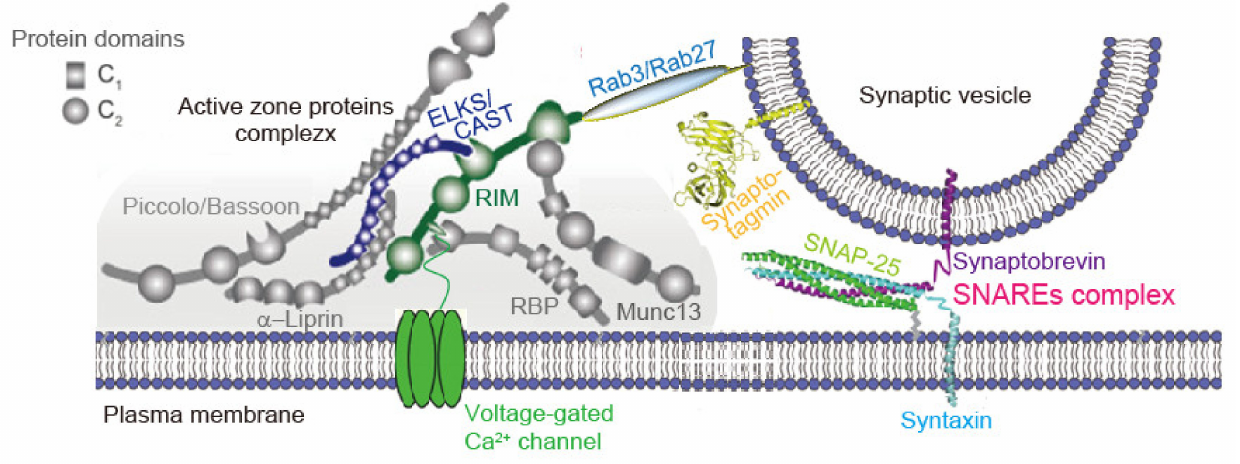
Figure 1. Presynaptic active zone assembly model and synaptic vesicle fusion machinery proteins. Diagram represents active zone (AZ) proteins’ complex in a liquid droplet (gray) and a docked synaptic vesicle (SV). A recent in vitro study indicates that SVs coat the surface of condensed liquid droplets [37]. In the droplet, the AZ is a highly organized structure that recruits voltage-gated Ca 2+ channel and docks SV. Reproduced with permission from ref. [3]. Copyright 2016, Wang et al. Priming factors promote proper assembly consisting of the pre-fusion state of the fusion machinery protein complex and SNAREs/synaptotagmin/complexin (not shown) [38]. The tight spatial organization ensures fast exocytosis upon Ca 2+ entry, and it provides molecular machinery to set and regulate synaptic strength, presynaptic short-term plasticity, and homeostatic synaptic plasticity. For detailed order of events of vesicle tethering, docking and fusion, please refer to reviews